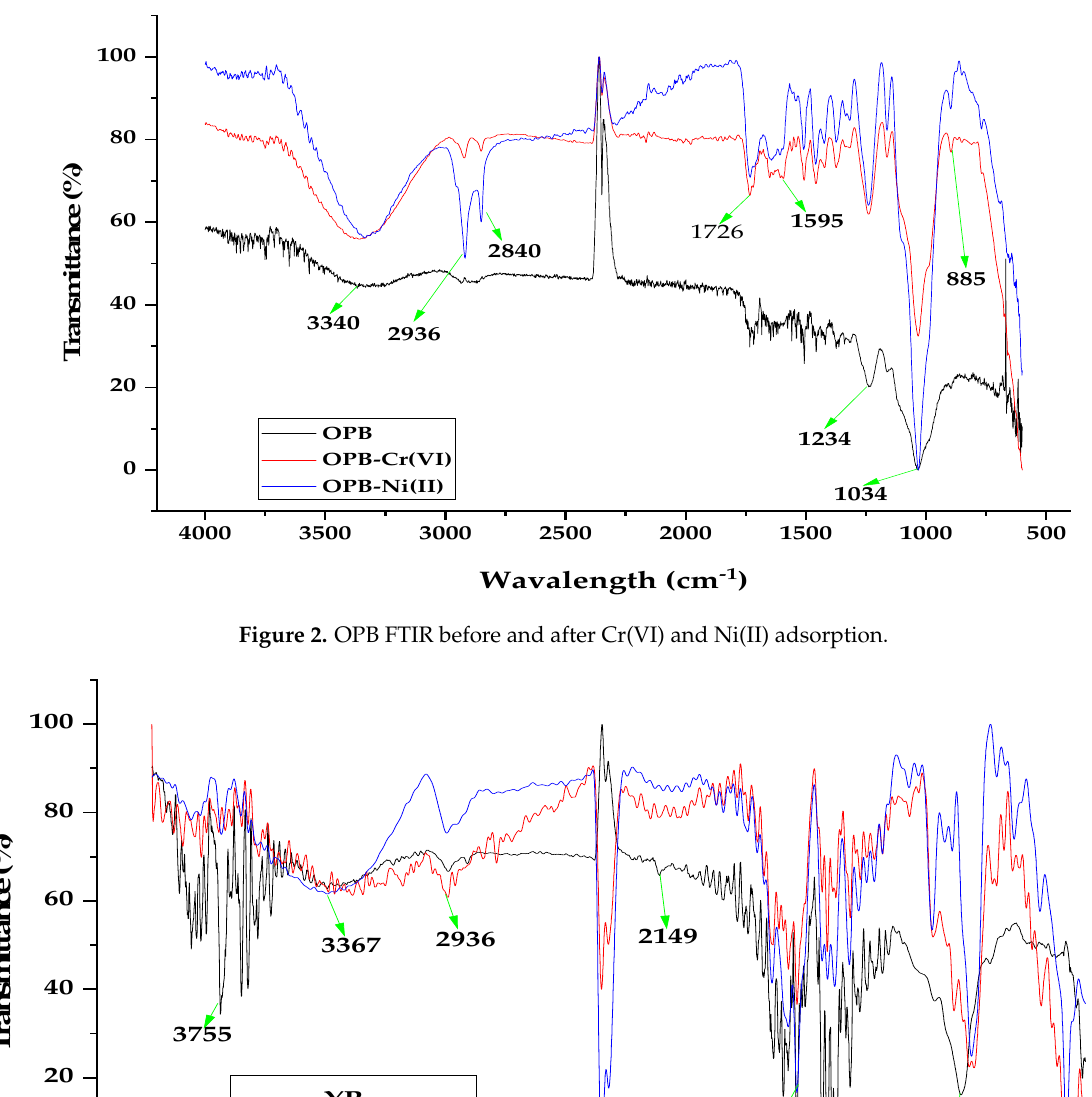
presence of aromatic rings in the lignin and stretching of the C-O groups can be observed [4]. The vibrations of the bands between 700 and 1300 cm − 1 present inorganic groups [36].